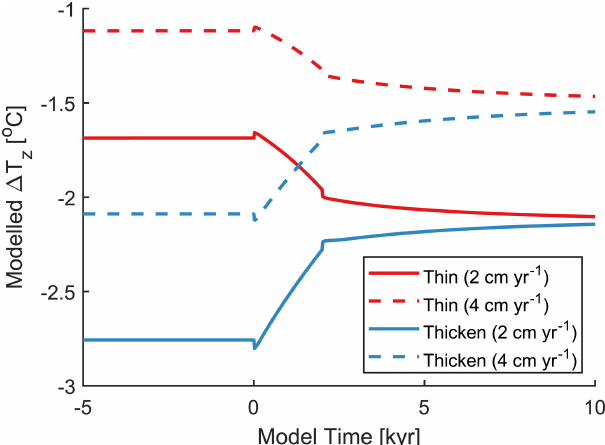
Figure 5. Modeled firn temperature difference for a thickening (blue lines) or thinning (red lines) of the ice column. Solid lines correspond to experiments with an accumulation rate of 2cmyr − 1 , and dashed lines correspond to an accumulation rate of 4cmyr − 1